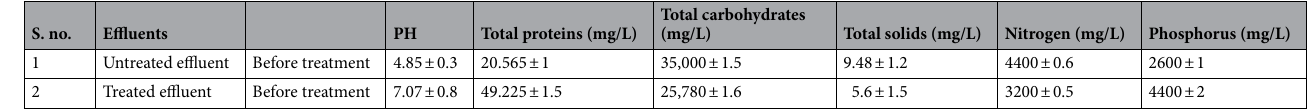
Table 2. Physiochemical characterization of beverage effluent.